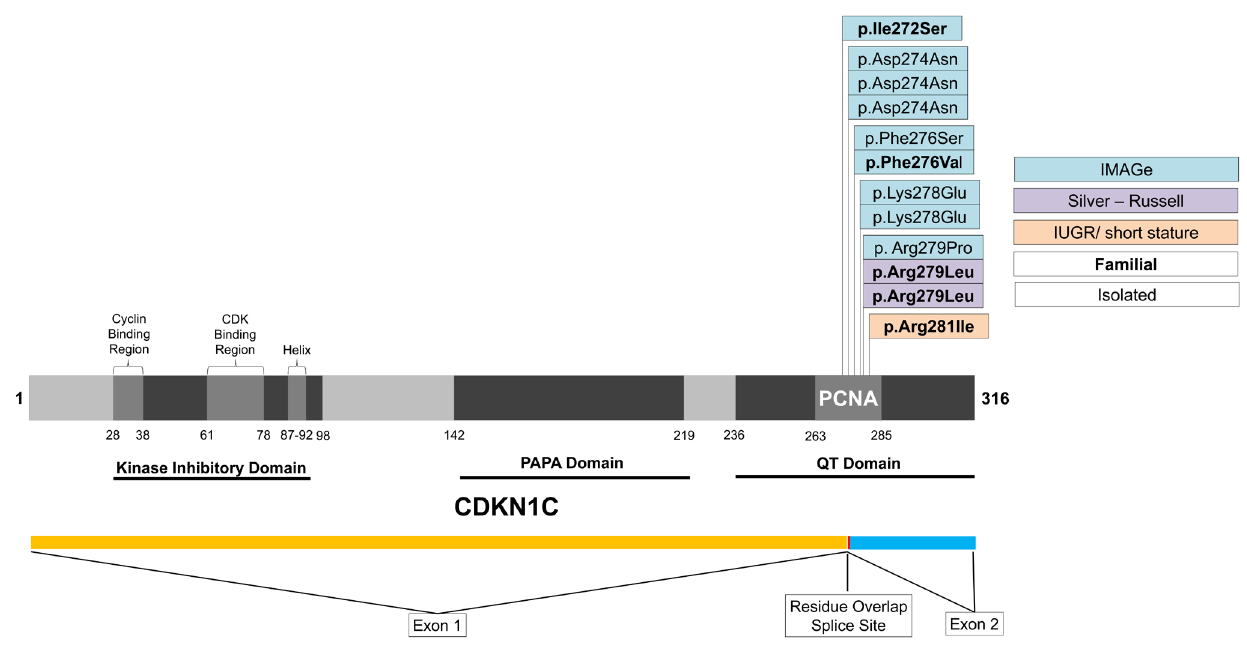
Figure 1. Schematic diagram showing the structure of CDKN1C and the clustering of pathogenic variants associated with IMAGe syndrome and/or growth restriction.